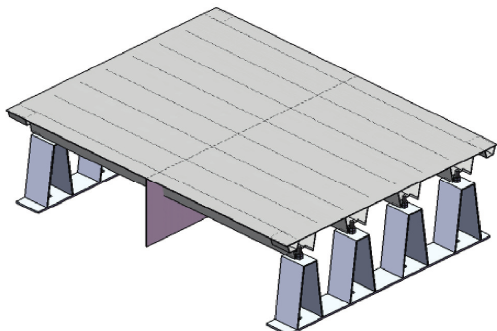
Figure 18: Effect diagram of the full-scale structure test model.